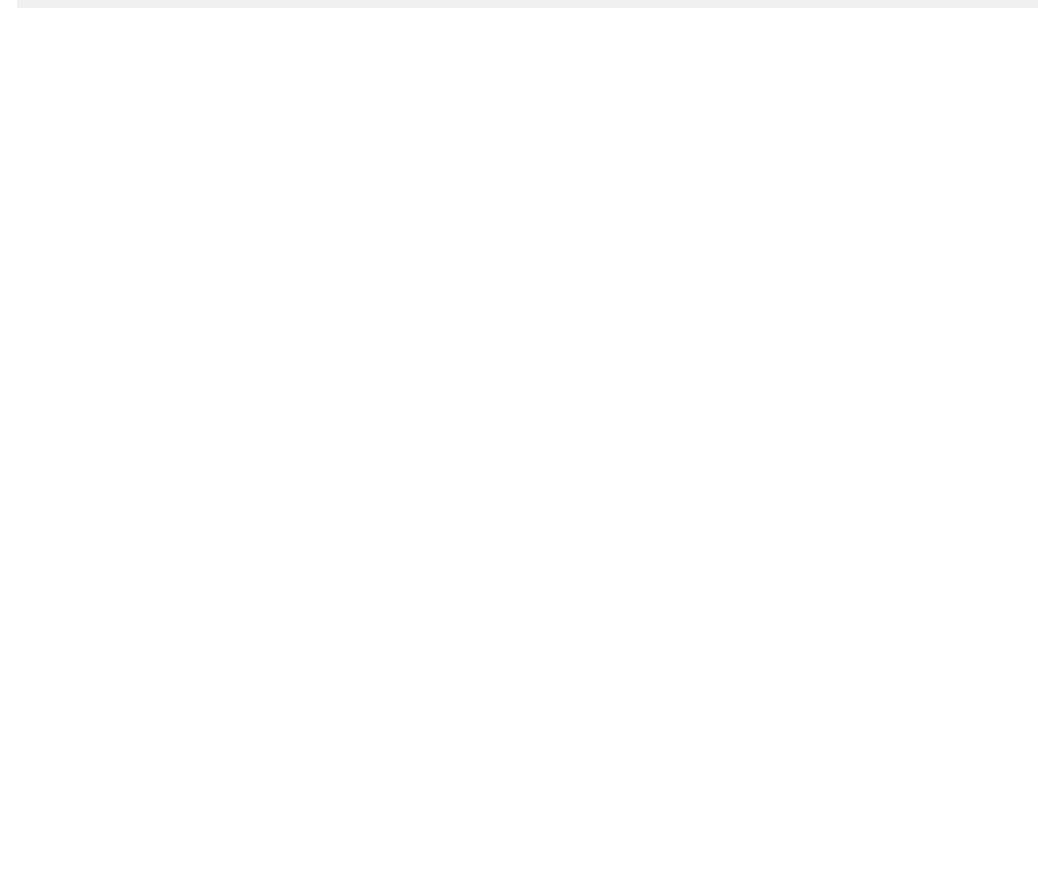
Figure 2 Fall height in correlation to ISS Score. Heights 4.0